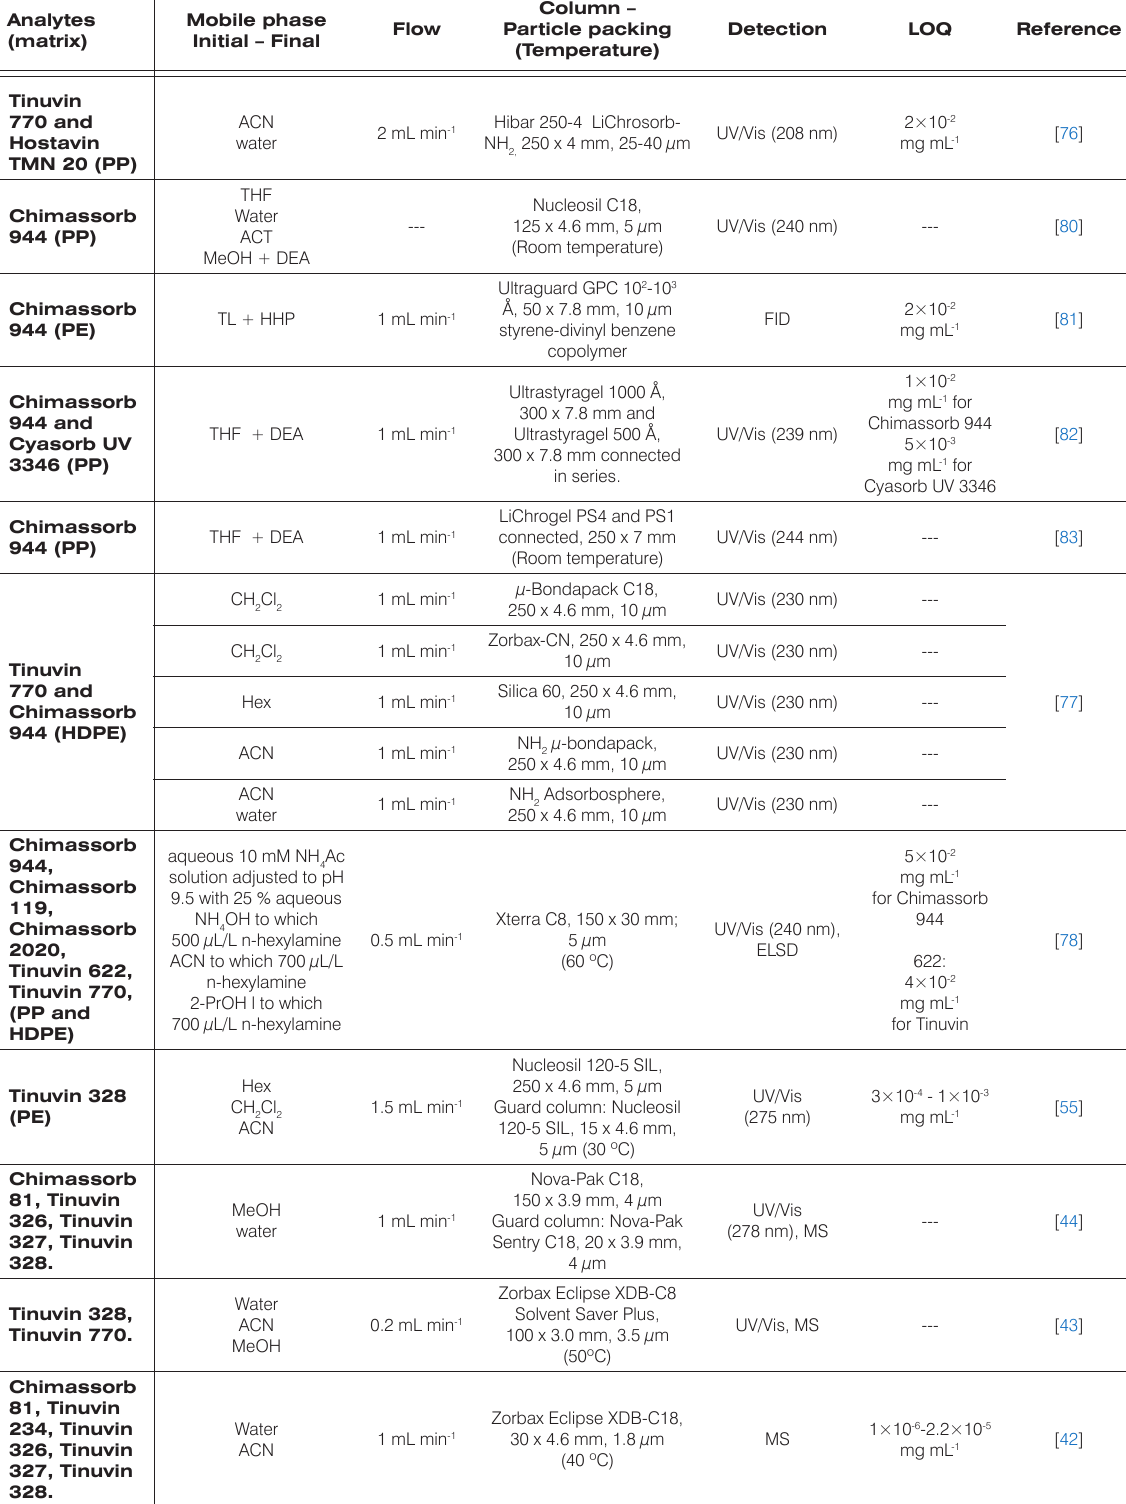
Table 3. Summary of liquid chromatography based methods for the determination of ultraviolet light stabilizers in plastics. Analytes